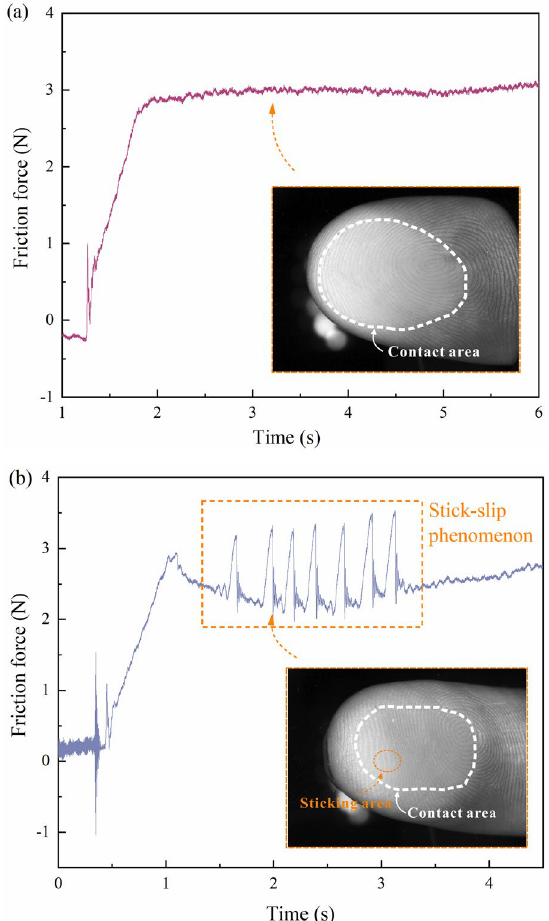
Figure 12 Friction force and contact area measured during the finger sliding ( a ) in the proximal and ( b ) distal